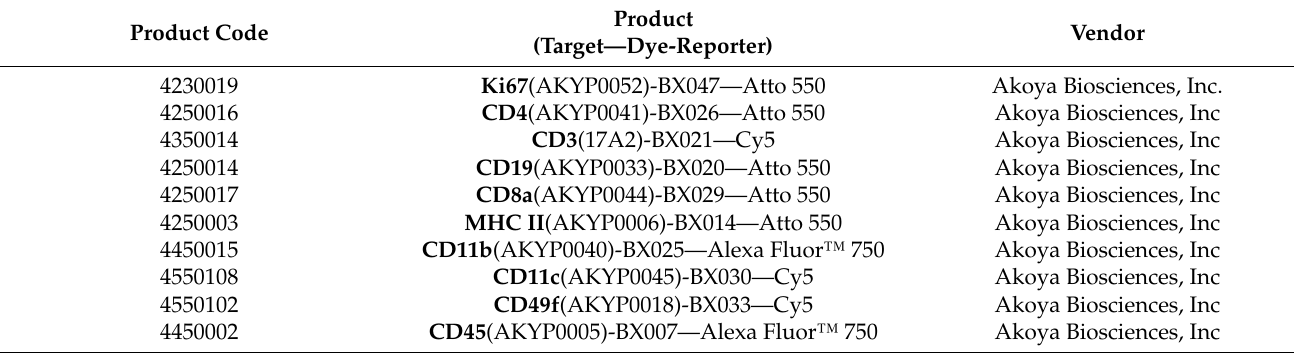
Table 1. List of the anti-mouse antibodies